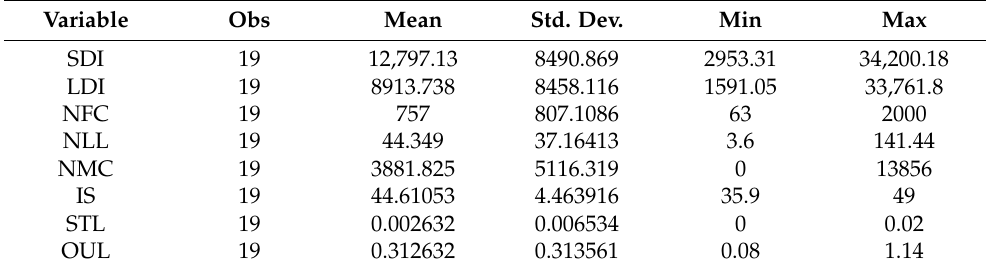
Table 4. Descriptive statistics of DMU inputs, outputs, and environmental